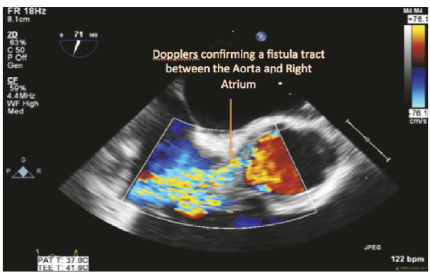
Figure 3: Concern for presence of an abnormal tract from the aorta.